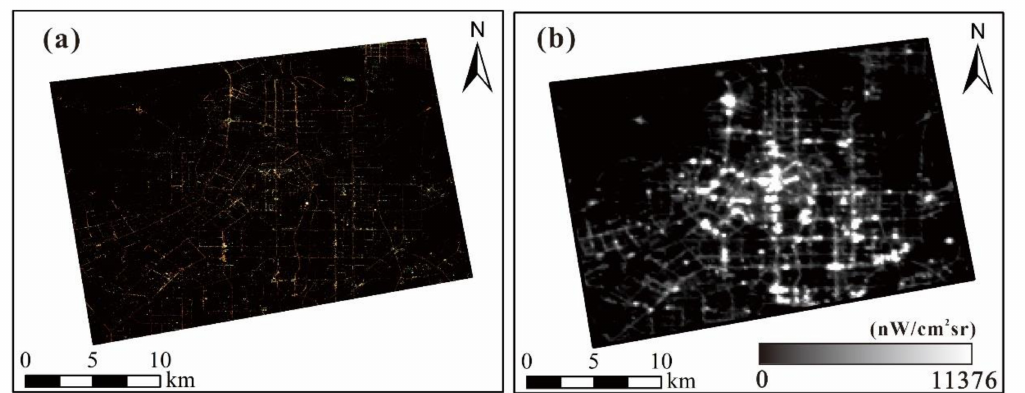
Figure 2. Two kinds of nighttime lights (NTL) data in the study area: ( a ) JL1-3B; ( b ) Luojia